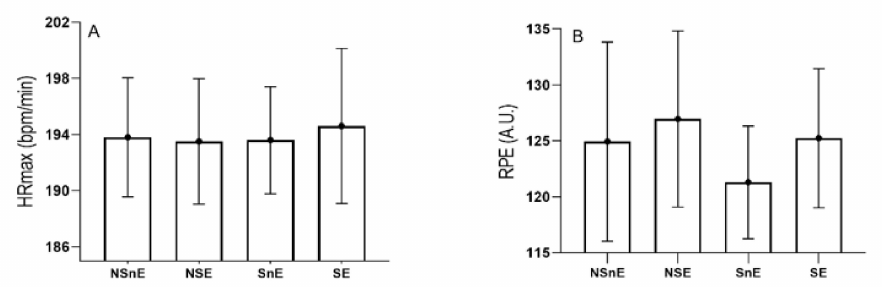
Figure 2. Descriptive Mean and SD of recorded internal load of the acute intense exercise using ( A ) HRmax and ( B ) RPE for each group separately. NSnE = non-smokers that did not exercise; NSE = non-smokers that did exercise; SnE = smokers that did not exercise; SE = smokers that did exercise; RPE = Ratings of Perceived Exertion; A.U. =Arbitrary unit.